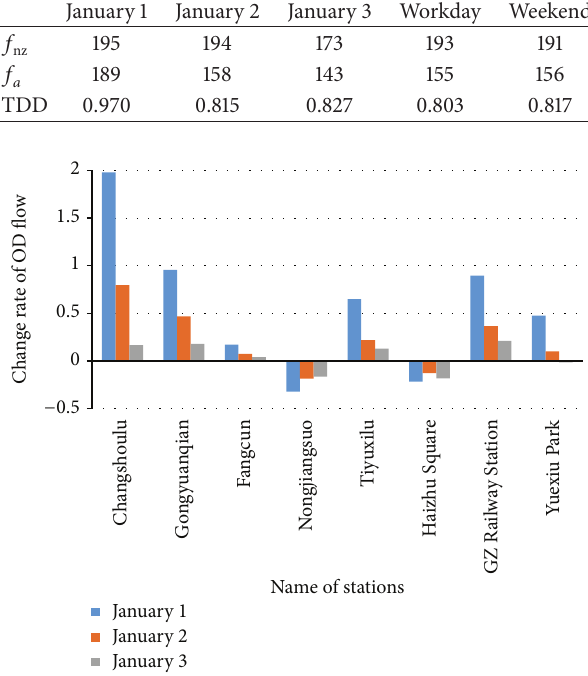
Figure 2: Change Rate of OD passenger flow compared with workdays.